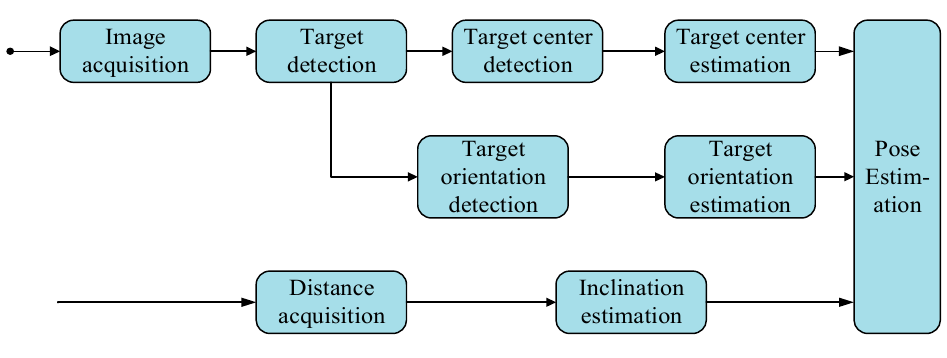
Figure 3. Vision system work process.